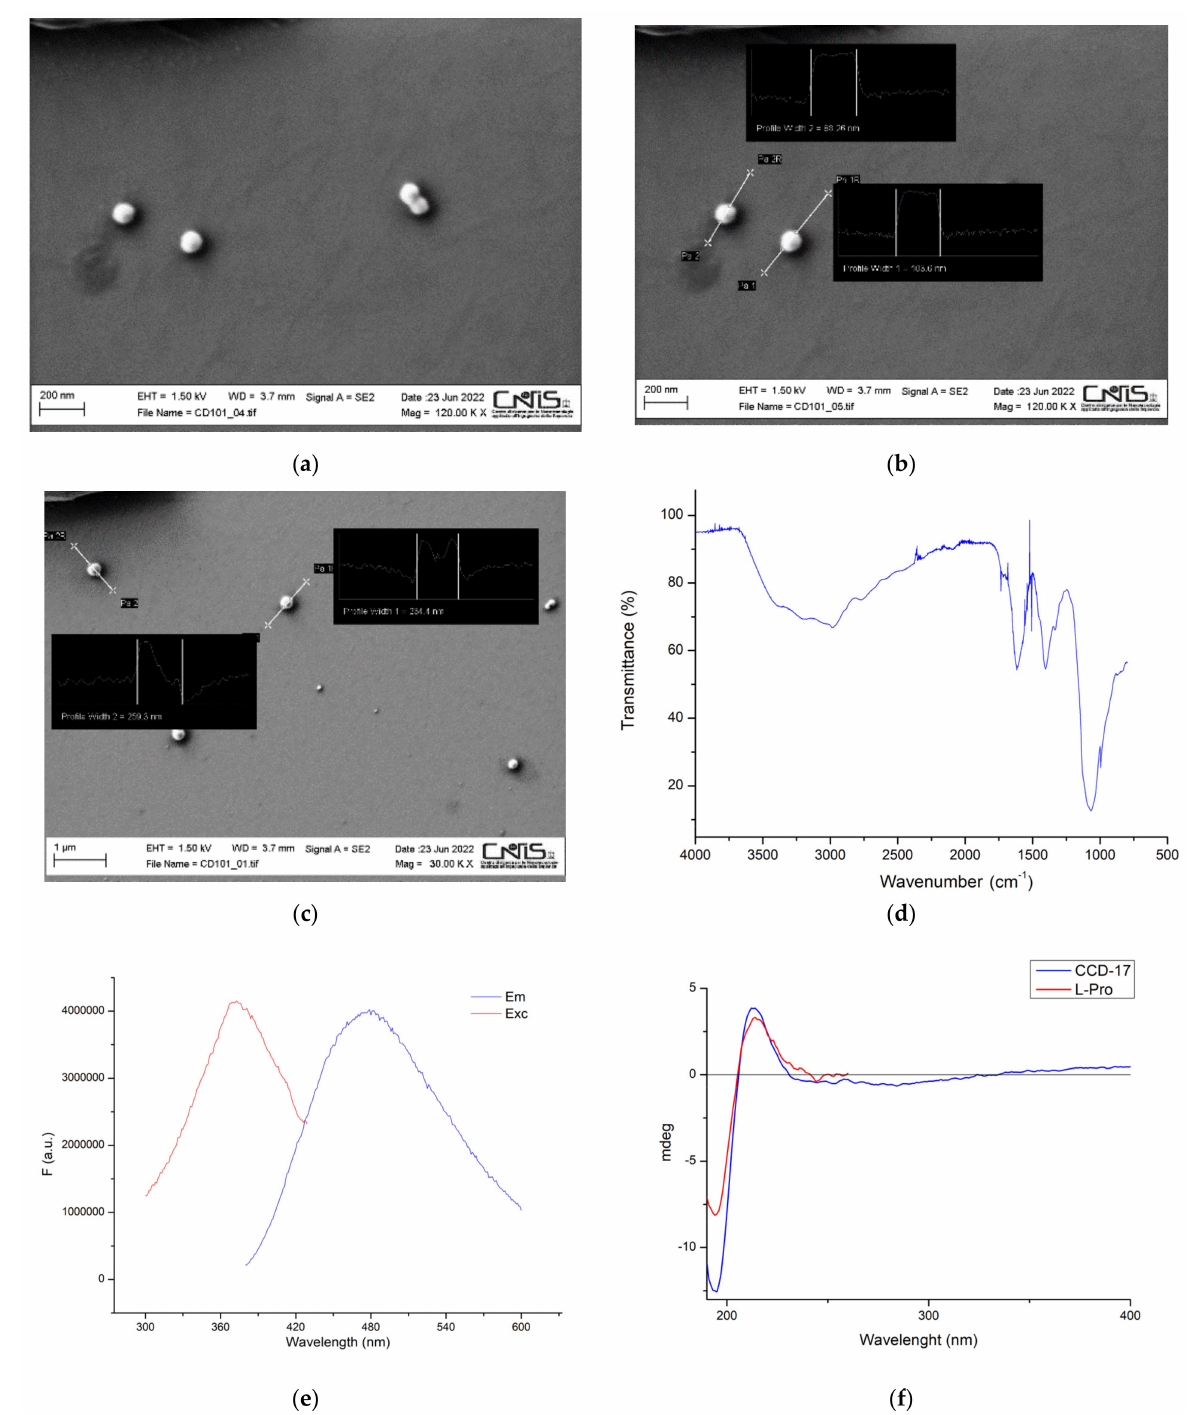
Figure 1. ( a–c ) Scanning electron microscopy (SEM) images of the electrochemically synthesised CCD-17 ; ( d ) IR spectrum of CCD-17 ; ( e ) Fluorescence excitation (red line) and emission (blue line) spectra of CCD-17 (2 mg/mL); ( f ) Circular dichroism spectra of L-Pro (0.3 mM) and CCD-17 (1 mg/mL) (red and blue line,